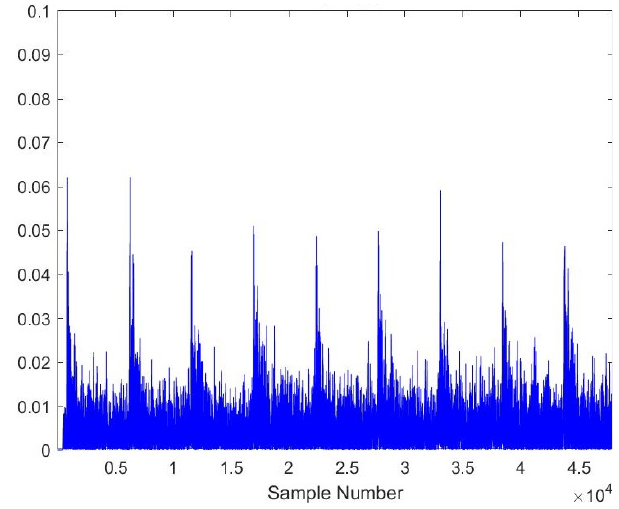
Figure 8. RMS plot of Softwood, Average Tool, 2 mm depth-of-cut.